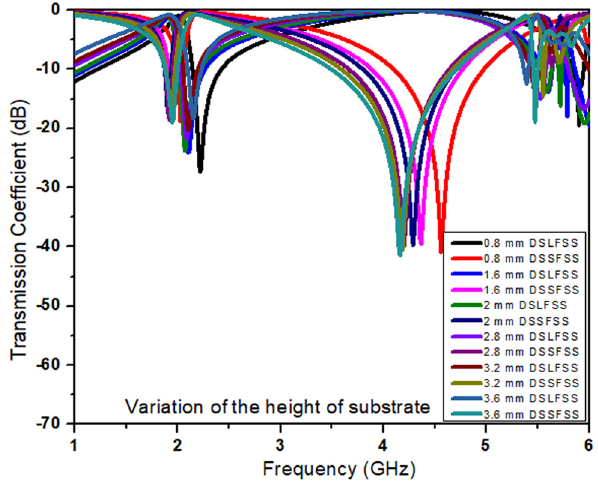
Figure 10: Variation in the transmission coe ffi cient characteristics of the CPFSS structure at di ff erent thicknesses ( H ) of the dielectric